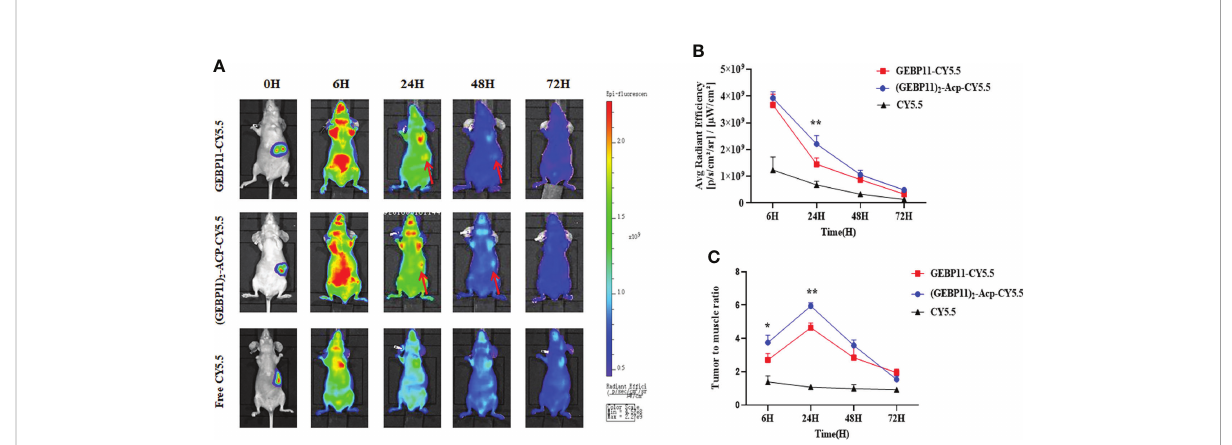
FIGURE 4 Targeting speci fi city of free Cy5.5, GEBP11-Cy5.5 and (GEBP11) 2 -Acp-Cy5.5. (A) fl uorescence imaging of orthotopic tumor-bearing nude mice after injection with probes. (B) Total fl uorescence signal emitted from the tumor site over time. (C) tumor-to-muscle ratio of the series probes over time. * p < 0.05; ** p < 0.01.